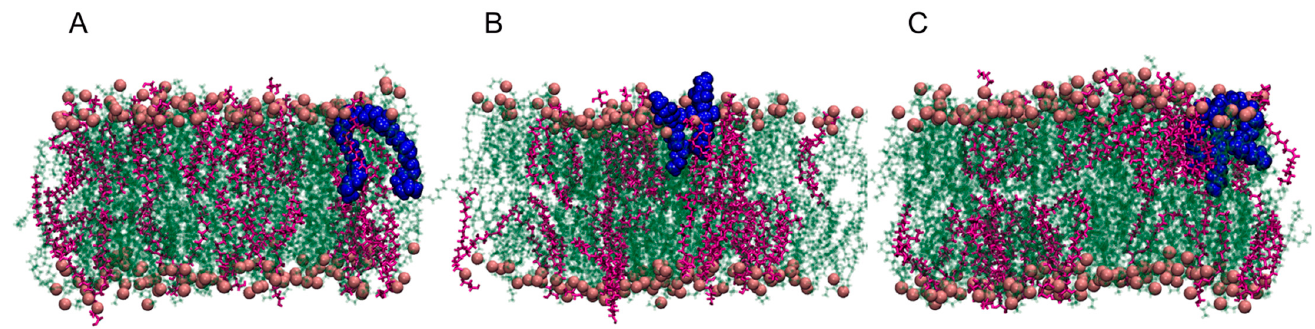
Figure 2. Selected screenshots of the systems with incorporated molecules, ( A ) Ole, ( B ) tQS, ( C )